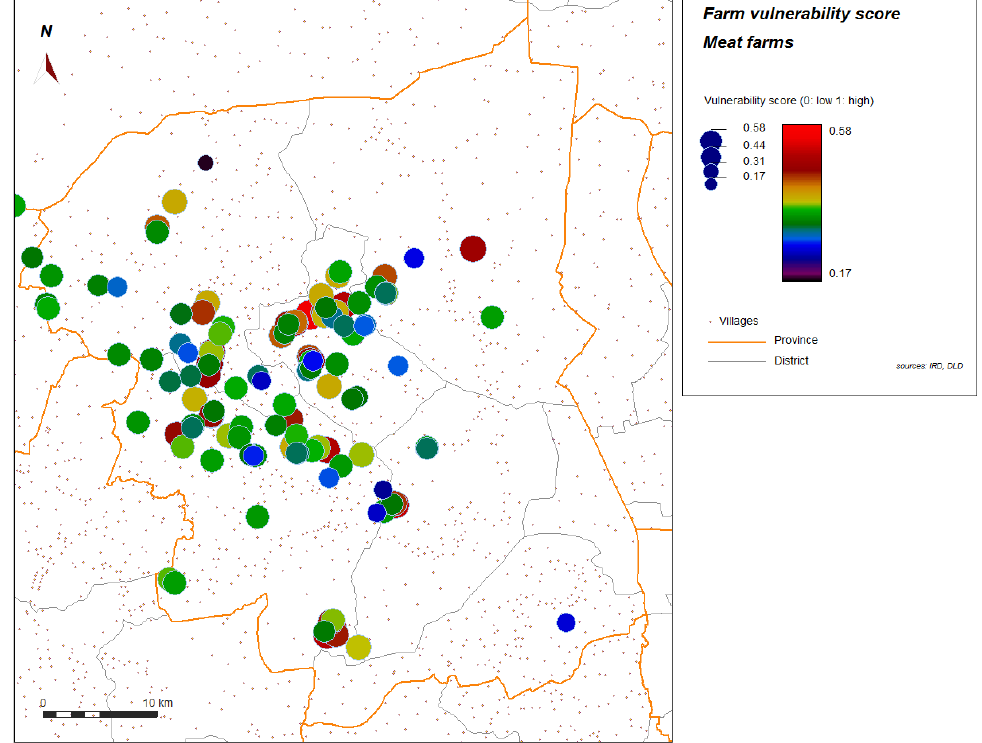
Figure 5. Score of vulnerability, meat farms sector 2 and 3, Nakhon Pathom province, Thailand. Level of vulnerability is given by color graduation and symbol width.